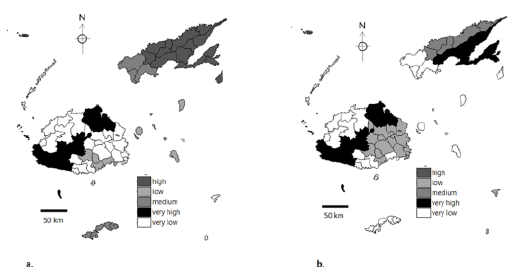
Figure 14a . LUI of farms of 3-5ha. Figure 14b. LUI of farms of 5-10ha farm size ranges.